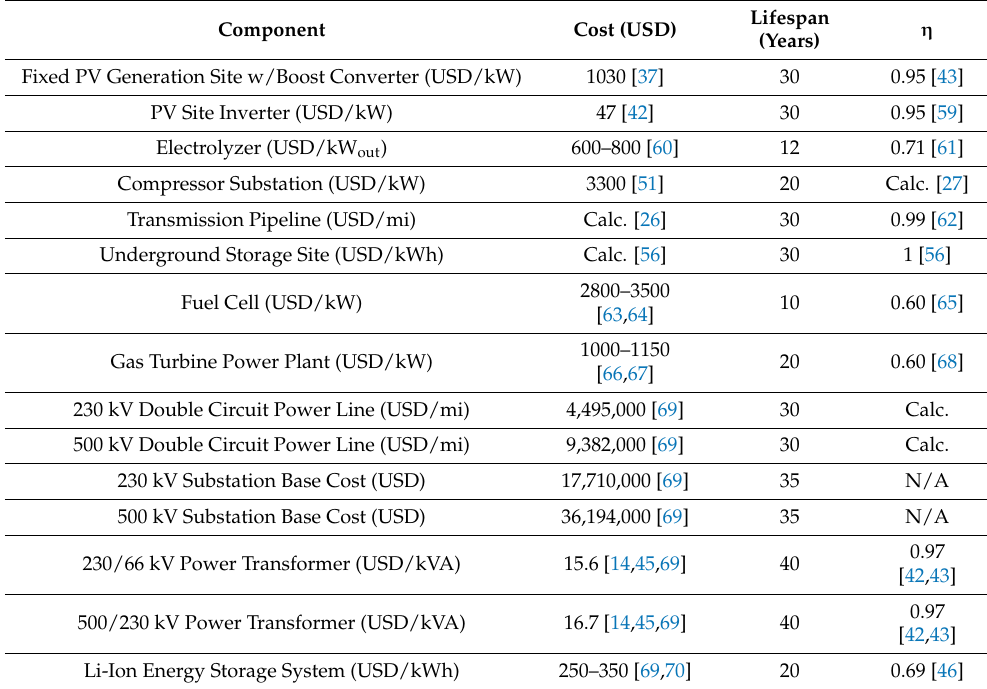
Table 1. Pathway major components